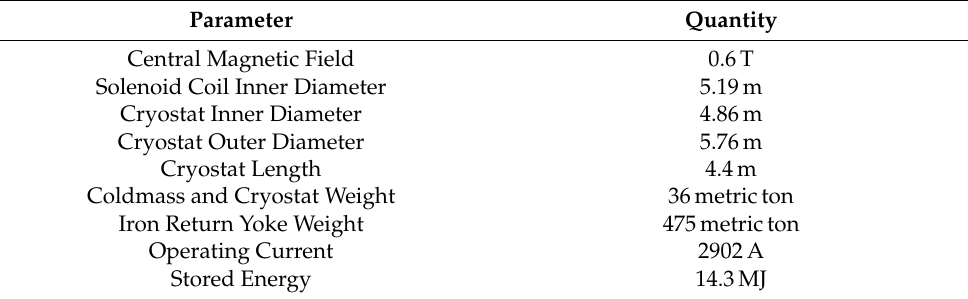
Table 25. Important SAND magnet